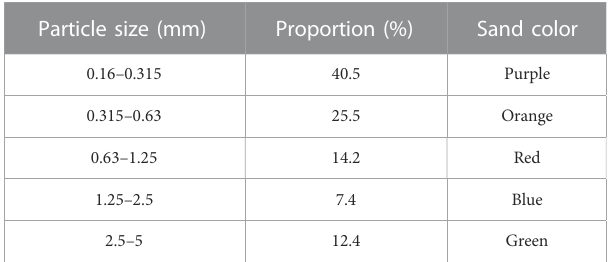
TABLE 3 Colored sand with different particle